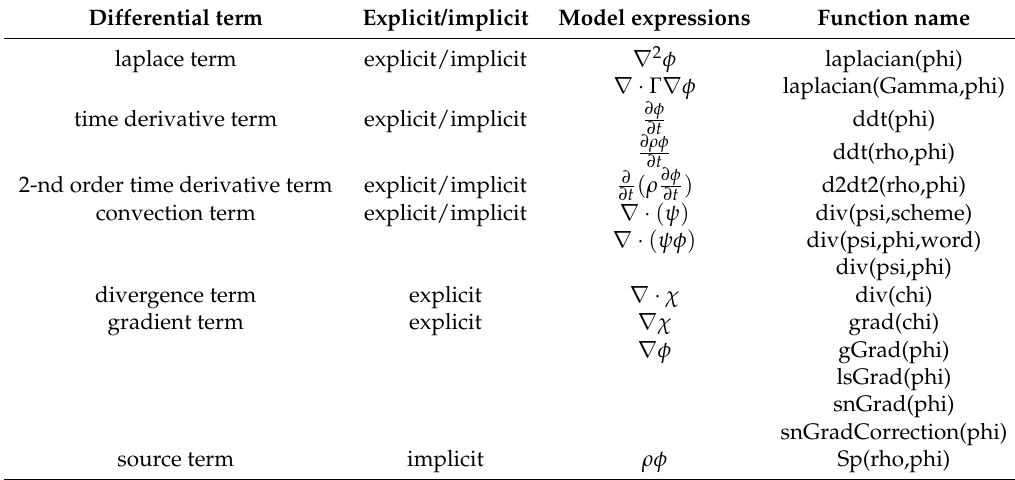
Table 1. The main partial differential equations discrete programming interface in